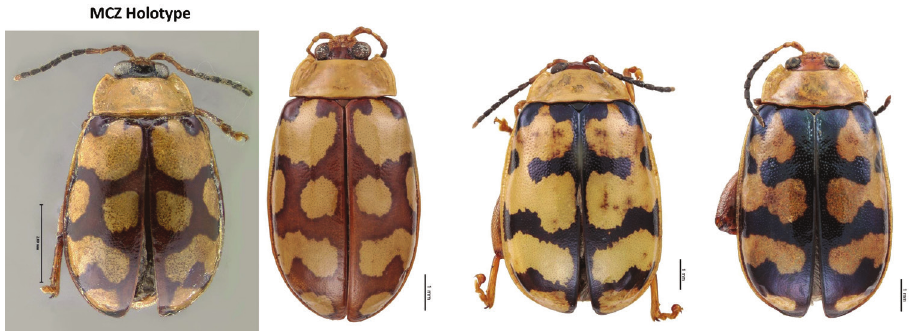
Figure 16. Alagoasa jacobiana (Horn) species confusion and intraspecific variation.